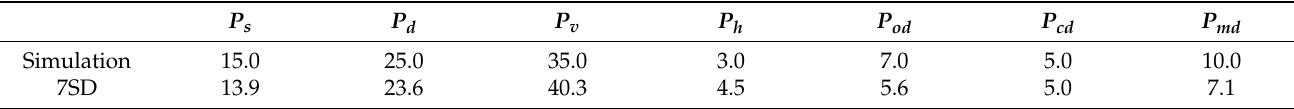
Table 5. The results of simulation data for 7SD